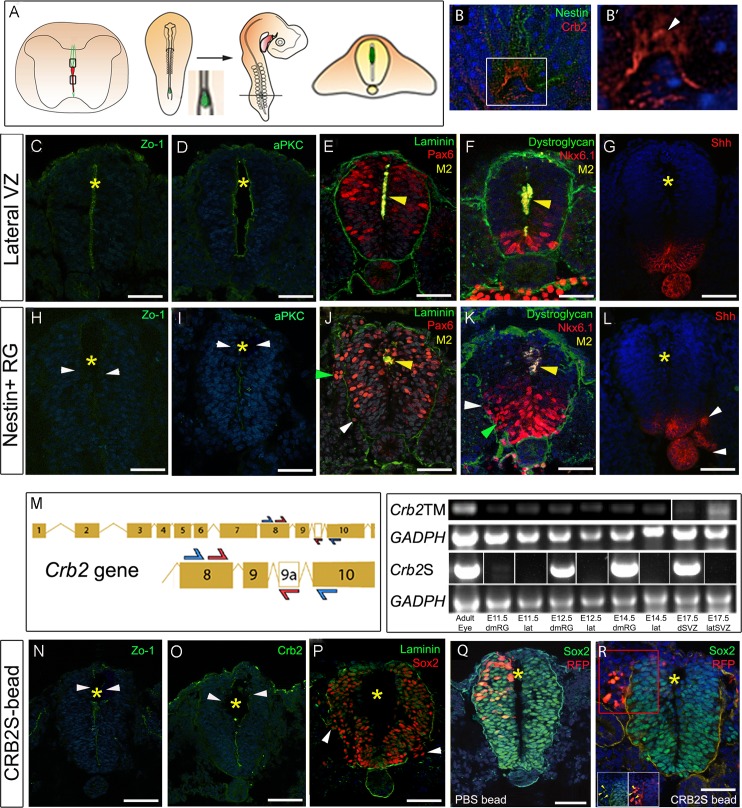
CRB2S from dmNes+RG promotes loss of polarity and delamination.(A) Schematic showing the grafting procedure: Mouse dmNes+RG or VL cells were dissected and grafted to Hamburger-Hamilton (HH) stage 10 chick embryos. After 20–24 hours of incubation (to HH stages 16–18), chicks were sectioned in the operated region, defined on the basis of the presence of or proximity to mouse tissue (all sections lie within 60 μm of mouse cells, analysed by α-M2 antibody; where tissue is present in section, it is marked by a yellow arrowhead; where not present, yellow asterisks show the position in a nearby section). (B-B′) Transverse sections of E16 mouse spinal cord double-labelled to detect Nestin and CRB2. Arrowhead in B′ points to non-apical CRB2 expression. (C-G) Transverse sections of HH stage 16–18 chick embryos after grafting control tissues, immunolabelled as shown. (C,D) Serial adjacent sections after a 20-hour incubation. Zo-1 and aPKC are detected on the apical side of neuroepithelial progenitor cells. (E-G) Serial adjacent sections after a 24-hour incubation. (H-L) Transverse sections of HH stage 16–18 chick embryos after grafting dmNes+RG. (H,I) Serial adjacent sections after a 20-hour incubation: little/no expression of Zo-1 and aPKC is detected (arrowheads). (J-L) Serial adjacent sections after a 24-hour incubation; ectopic Pax6(+) and Shh(+) cells are detected outside of the neural tube, the basement membrane shows breaks, and Nkx6.1(+) cells are disorganised (arrowheads). Underlying data can be found in S5 Table. (M) Left-hand panel: Schematic showing primer strategy against Crb2 or Crb2S. CRB2S has an additional exon alternatively spliced into the transcript. Blue arrows indicate a first round of PCR amplifying a band between exon 8 and 10 present in both Crb2 cDNA and Crb2S cDNA. Nested primers are indicated by red primers, which amplify between exon 8 and exon 9a, present in only Crb2S. Right-hand panel: Amplification (using the first round and nested primers) of adult eye, E11.5, E12.5, and E14.5 dmNes+RG (dmRG); E11.5, E12.5, and E14.5 lateral VL (lat); and dorsal or lateral E17.5 SVZ samples. A GADPH control is provided for both sets of primers in all samples. Crb2S lanes show representative images from 4 biological samples: see S7 Fig for full gel. (N-P) Transplanted CRB2S protein-soaked bead grafted to HH stage 10 chick embryo analysed after 24 hours. Zo-1 and Crb2 expression are reduced in the vicinity of the bead (N,O arrowheads). Sox2(+) neural progenitors are disorganised; some are detected outside the disrupted basement membrane (P, arrowheads). (Q) Control RFP electroporated and PBS-soaked bead-grafted HH stage 10 chick embryo after 24 hours shows normal expression of Sox2 throughout neural tube and normal basement membrane. (R) RFP electroporated and CRB2S-soaked bead-grafted HH stage 10 chick embryo after 24 hours shows ectopic expression of Sox2 outside neural tube and disrupted basement membrane. Red box indicates inset below. Yellow arrows indicate Sox2(+) RFP(+) cells outside the neural tube. Yellow asterisks in N-R shows position of bead (displaced on sectioning). Scale bars: C-L, N-R, 50 μm; B-B′, 10 μm. α-M2, anti-mouse astrocyte-surface antigen; aPKC, atypical protein kinase C; CRB2, Crumbs2; CRB2S, secreted Crumb2; dmNes+RG, dorsal midline Nestin(+) radial glia; GADPH, glyceraldehyde 3-phosphate dehydrogenase; Nkx6.1, NK6 homeobox 1; Pax6, paired-box 6; RFP, red fluorescent protein; RG, radial glia; Shh, Sonic hedgehog; Sox2, Sry-related HMG-box 2; SVZ, subventricular layer; VL, ventricular layer; VZ, ventricular zone; Zo-1, Zona occludens 1; (+), expressing.